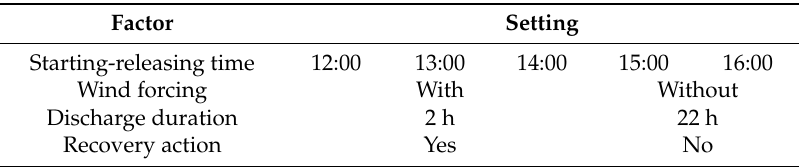
Table 1. The studied factors and their corresponding settings. Factor Setting Starting-releasing time 12:00 13:00 14:00 15:00 16:00 Wind forcing With Without Discharge duration 2 h 22 h Recovery action Yes